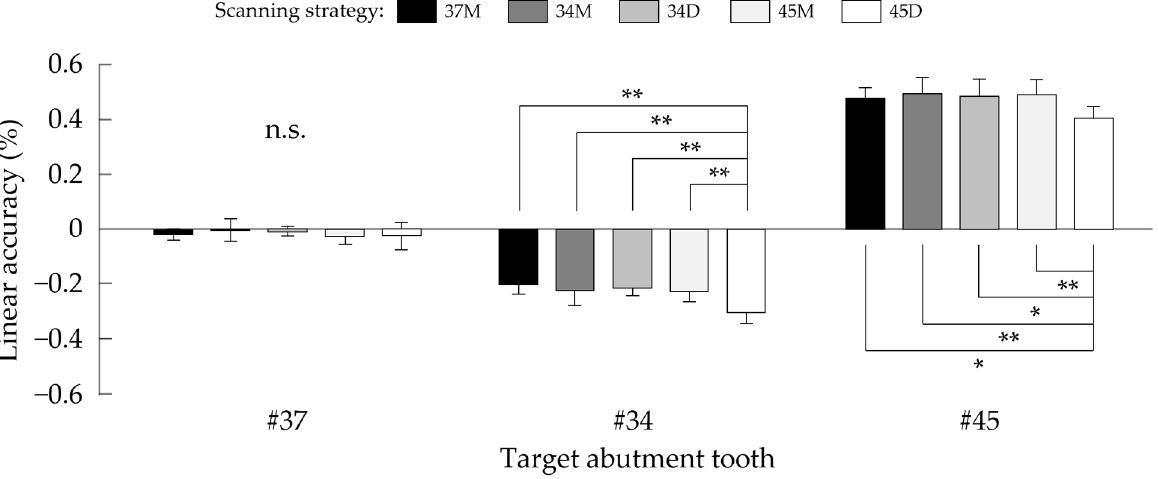
Figure 6. Results of the comparison of linear accuracy for each target abutment tooth among five scanning strategies. n.s.: not significant; *: p < 0.05; and **: p < 0.01.